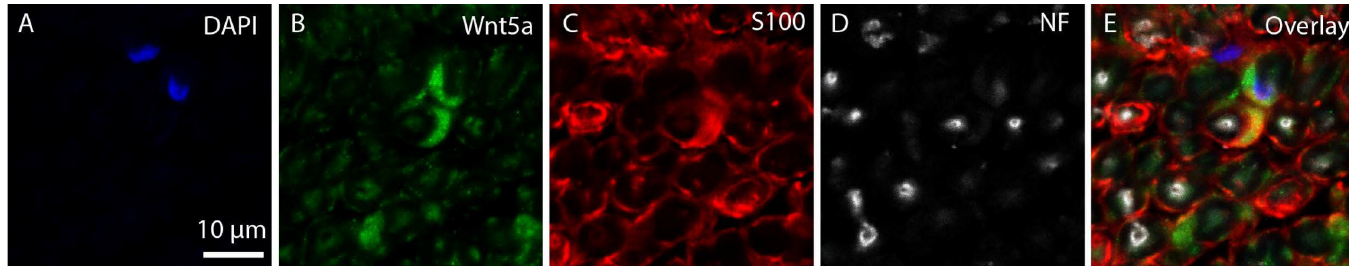
Fig 5. Wnt5a/b is expressed by Schwann cells in the injured rat nerve. A-E , Triple label Immunohistochemistry for Wnt5a/b, S100 and NF on transversal sections of rat peripheral nerve 28d after sciatic nerve crush. Wnt5a/b (B, green) is predominantly expressed in S100 positive Schwann cells (C, red) that enwrap neurofilament positive axons (D, white) in the injured rat nerve (E, overlay of panels A, B, C and D). Scale bar is 10 μ